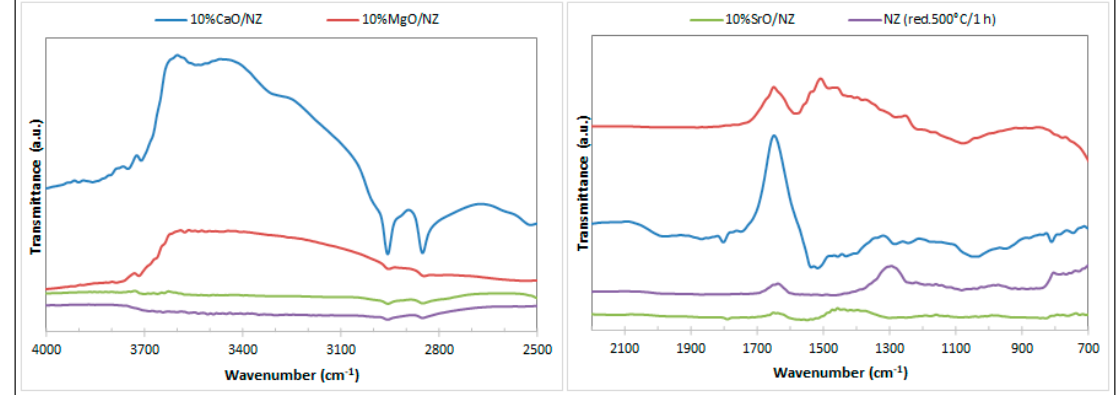
Figure 6. FTIR spectra of adsorbed species taken after exposure of the catalytic system (10% MgO/NZ, 10% CaO/NZ and 10% SrO/NZ) calcined in an air atmosphere at 400 °C for 4 h or natural zeolite reduced in a mixture of 5% H 2 –95% Ar at 500 °C, to a mixture of 5 vol % methanol–95% argon mixture at 50 °C and after the evacuation of this mixture for 15 min using argon stream.